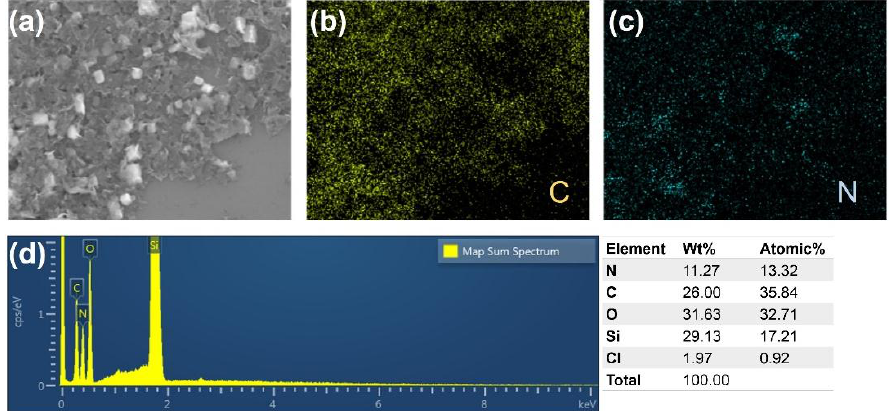
Figure 6. ( a ) Low-magnification SEM image of g-C 3 N 4 /graphene nanocomposite; ( b ) Carbon and ( c ) nitrogen elemental mapping captured in ( a ); ( d ) Energy-dispersive X-ray spectroscopy (EDS) pattern and elemental composition of nanocomposite.